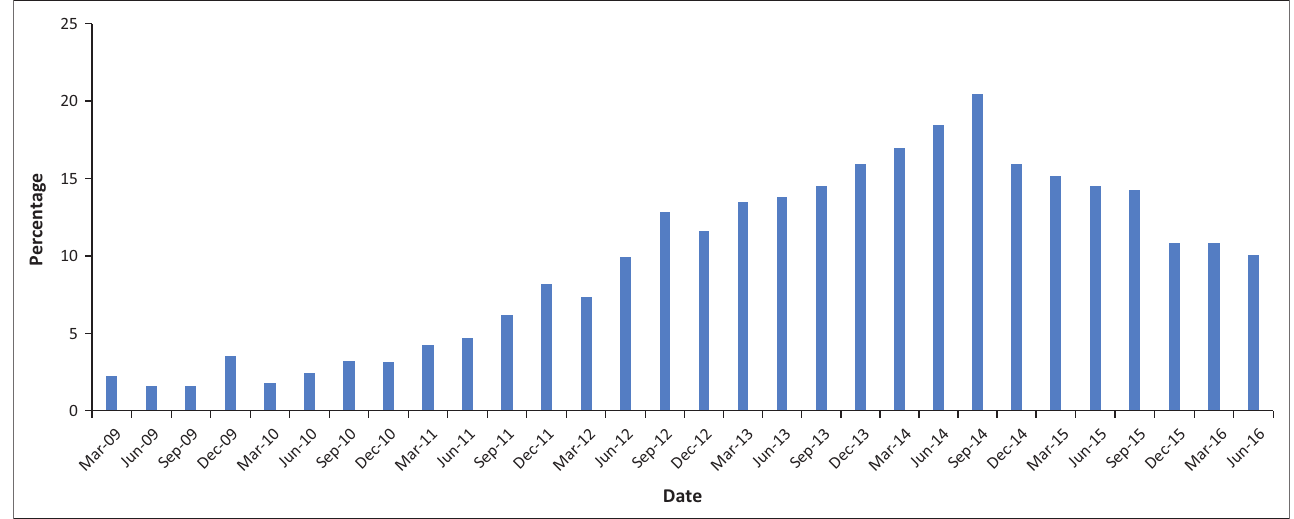
FIGURE 1: Non-performing